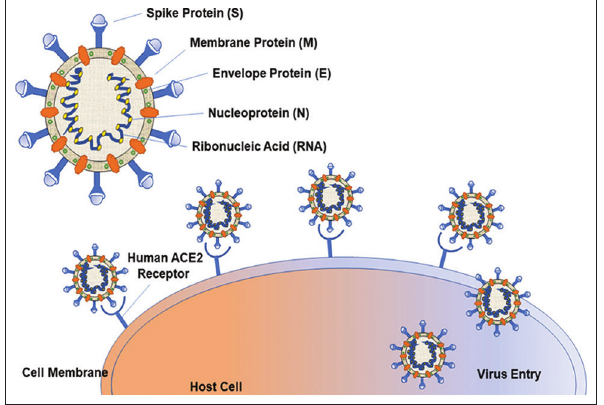
Figure-6: Cardiovascular involvement in coronavirus disease-19, key manifestations